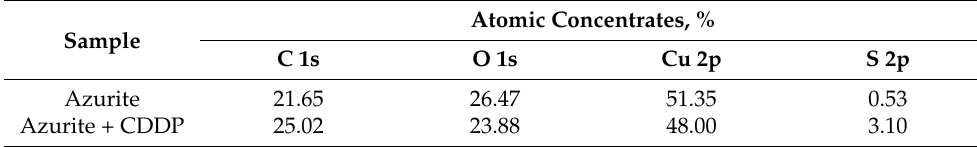
Table 2. The atomic concentrations of azurite and collector-treated azurite